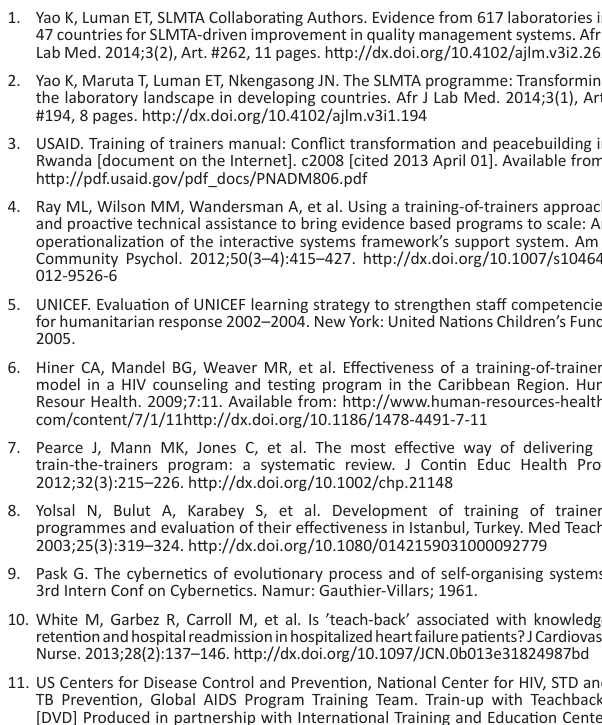
SLMTA, Strengthening Laboratory Management Toward